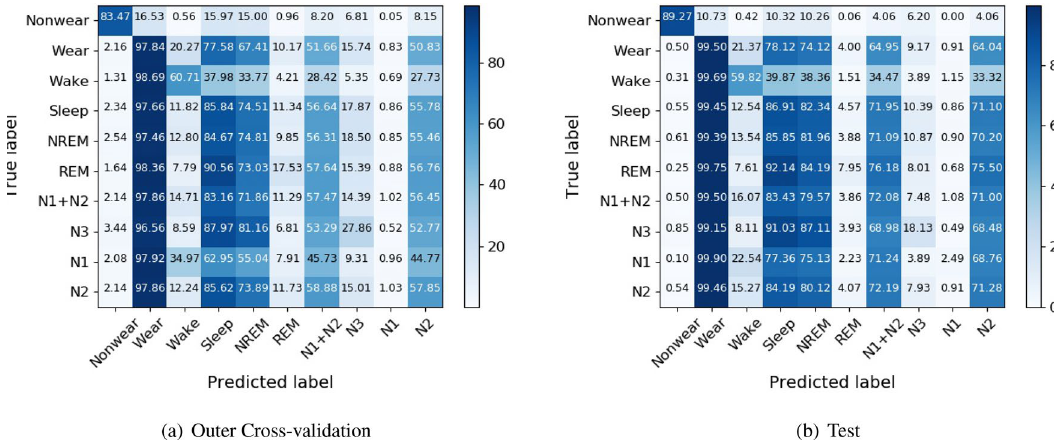
Figure 3. Confusion matrices for hierarchical